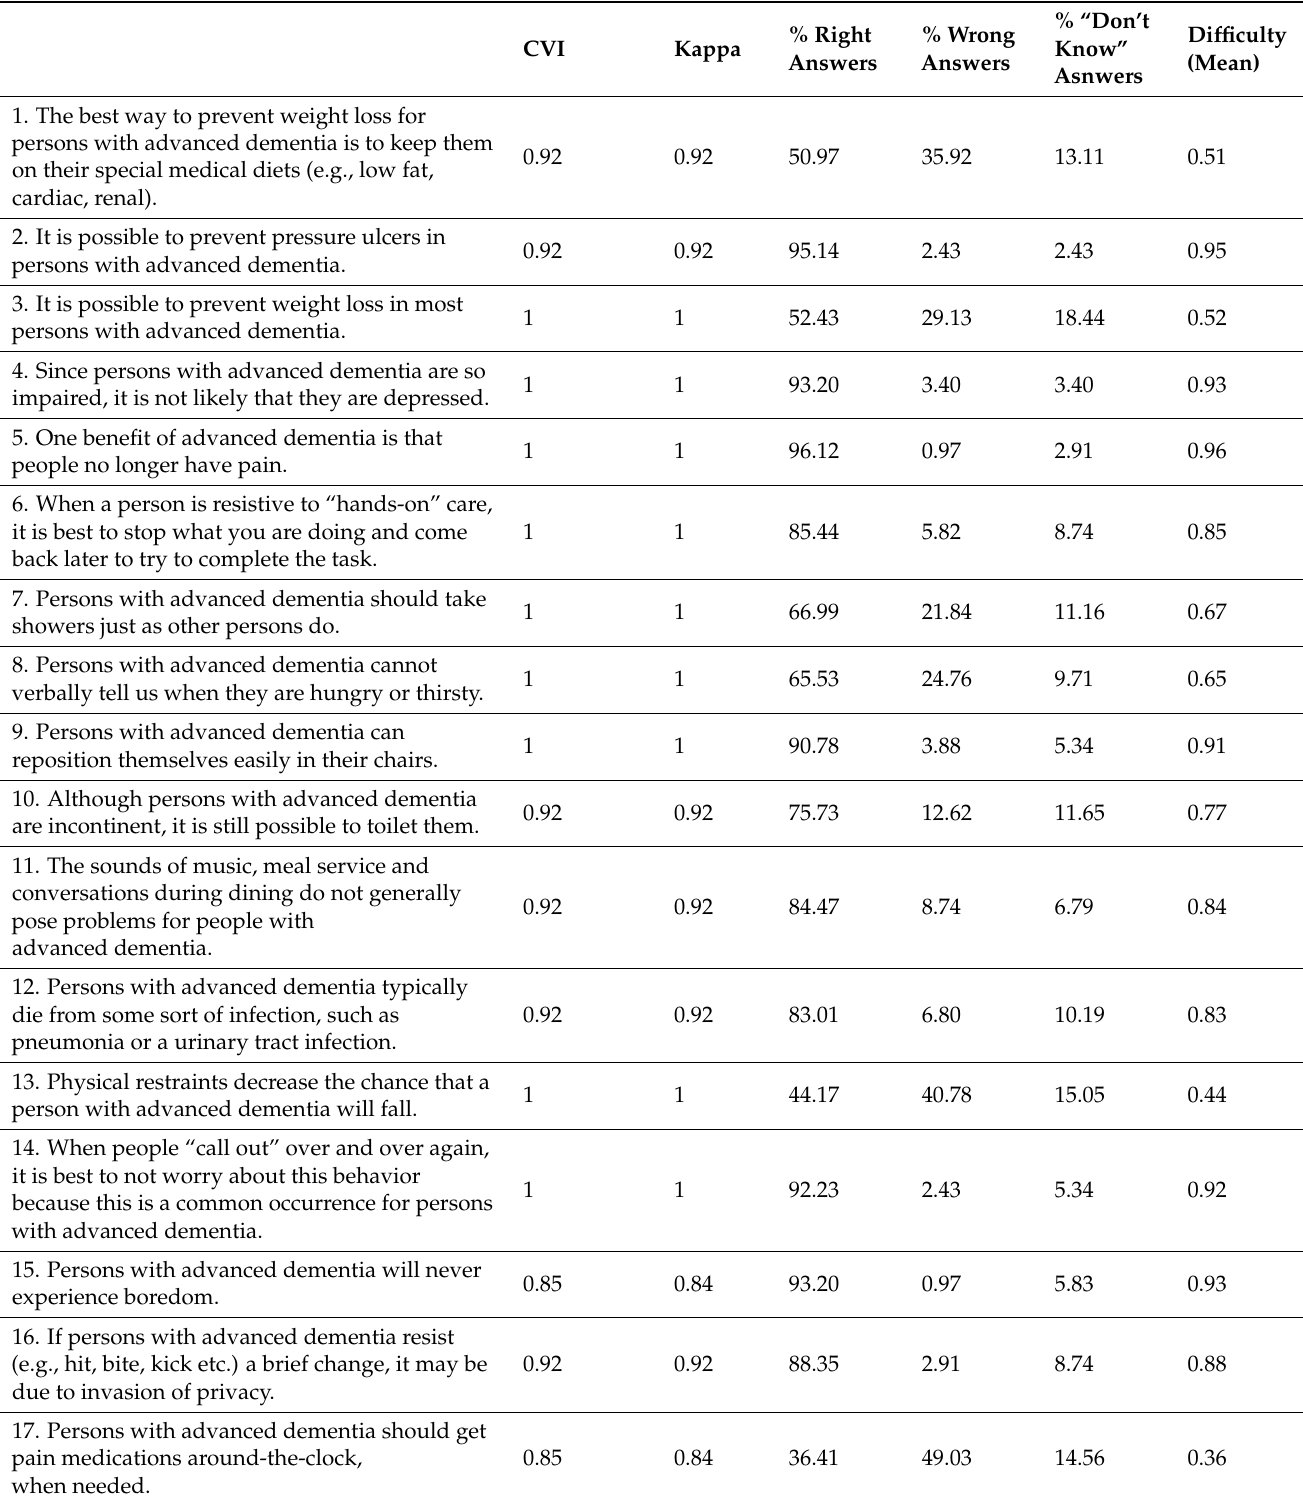
Table 1. Knowledge of palliative care in advanced